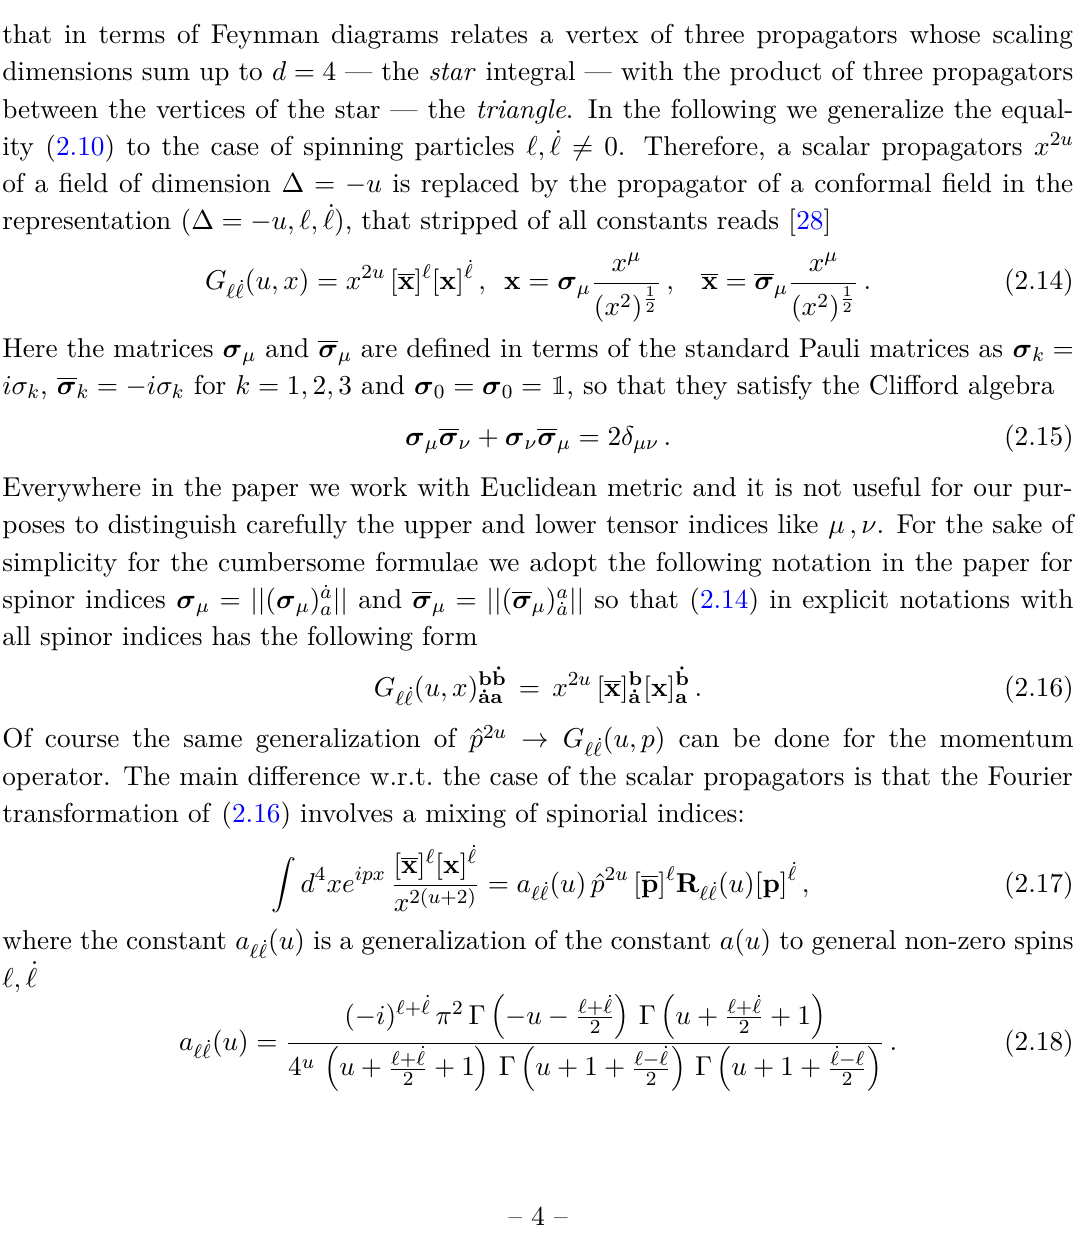
Figure 1 . Left: convolution of three scalar propagators corresponding to the l.h.s. of the dual- ity (2.13). Each solid segment is 1/ x 2 endpoints of the segment. Right: product of three propagators corresponding to the r.h.s. of (2.13) modulo a multiplicative